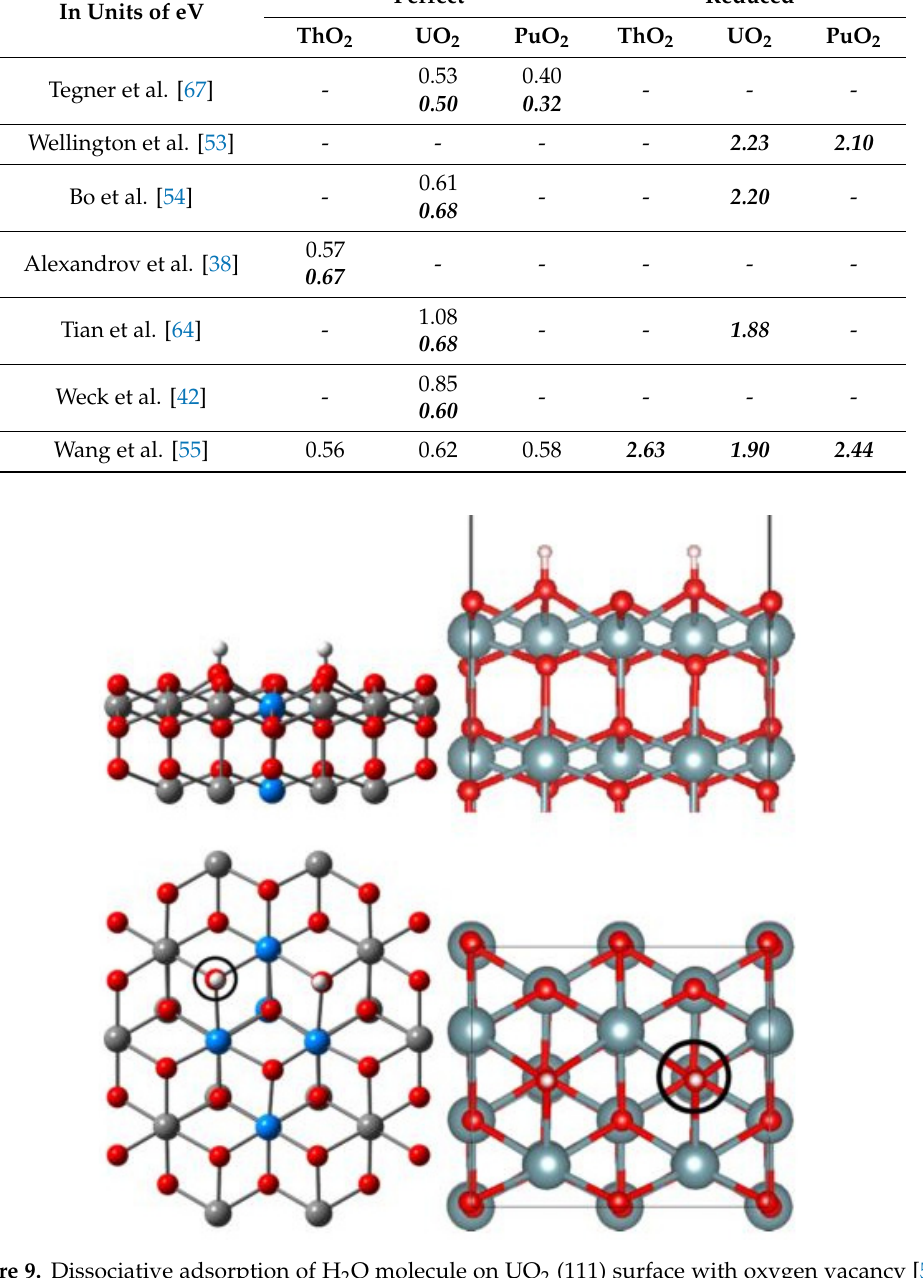
Figure 9. Dissociative adsorption of H 2 O molecule on UO 2 (111) surface with oxygen vacancy [53]. The left is the side and top views using the embedded cluster model, the right is using the periodic model. The position of the oxygen vacancy is indicated with a black circle. Table 6. Adsorption energies of one H 2 O molecule on AnO 2 (111) surface. The bold italic numbers correspond to the dissociative adsorption energies. The rest are the molecular adsorption energies. In units of eV